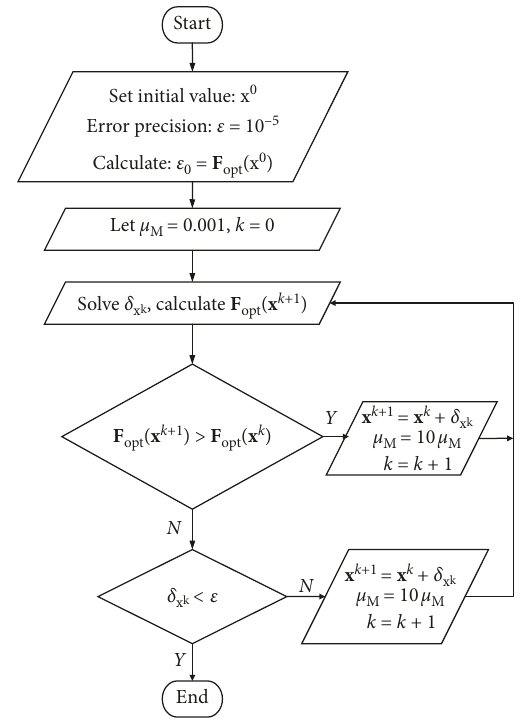
Figure 2: Flowchart of inversion using the LM optimization